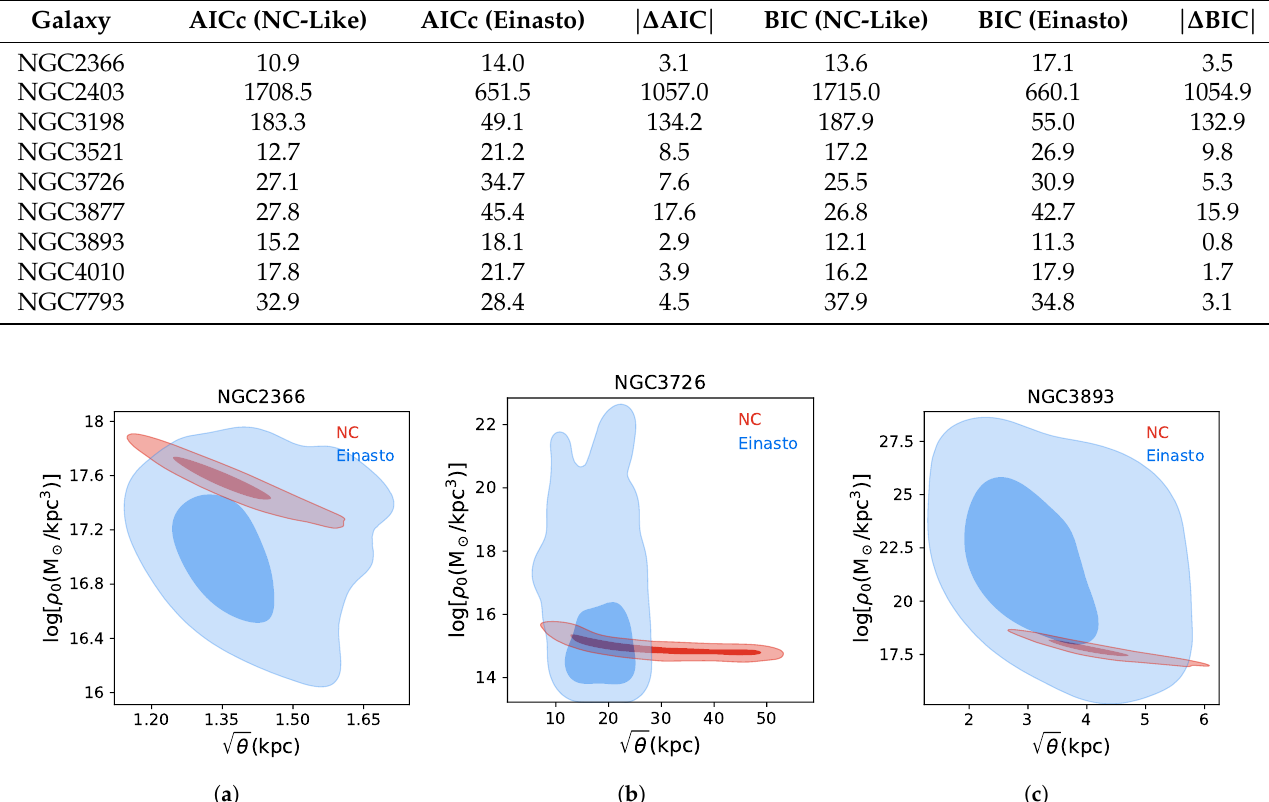
Figure 3. Correlation of the parameter model ( ρ 0 and 1 σ and lighter region is 3 σ